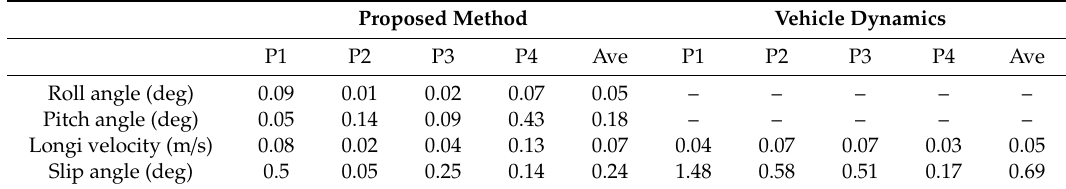
Table 2. Absolute estimation errors during critical steering in slalom maneuver.